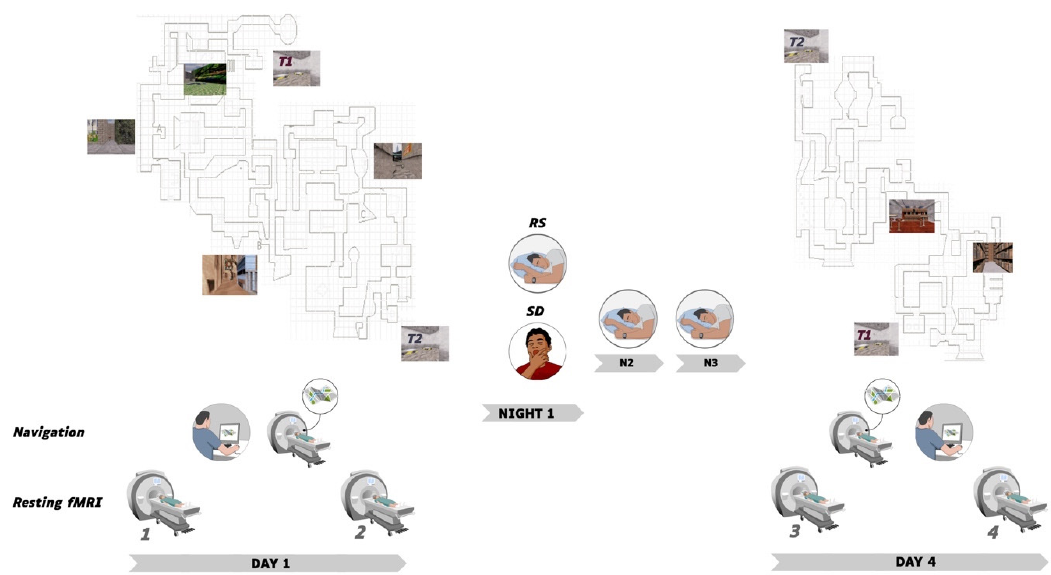
Figure 1. Experimental Protocol. On Day 1, 50 participants were scanned in the resting state before (rsfMRI 1) and after (rsfMRI 2) out-of-scanner exploration of Level 1 of the virtual town, followed by fMRI Test 1 (immediate retrieval navigation test). Thirty-four participants then either slept normally (RS) or were sleep deprived (SD) during Night 1, and then slept normally on Nights 2 and 3. On Day 4, RS and SD participants were scanned in the resting state (rsfMRI 3) followed by fMRI Test 2 (delayed retrieval navigation test). Afterward, they were trained on an extended version (both Level 1 and 2) of the virtual town and then scanned a last time in the resting state (rsfMRI 4). Finally, participants were tested on the extended version of the virtual town outside of the MRI environment (Retrieval extended, not illustrated). Top left and right panels provide an aerial representation of the town map (not seen by participants who navigated from within the environment, see sample pictures) with Level 1 (left, day 1) and 2 (right, day 4) environments and navigation test targets A, B and C located on the 1 st level. At Day 4, Level 1 and 2 communicated through teleporters T1 and T2.